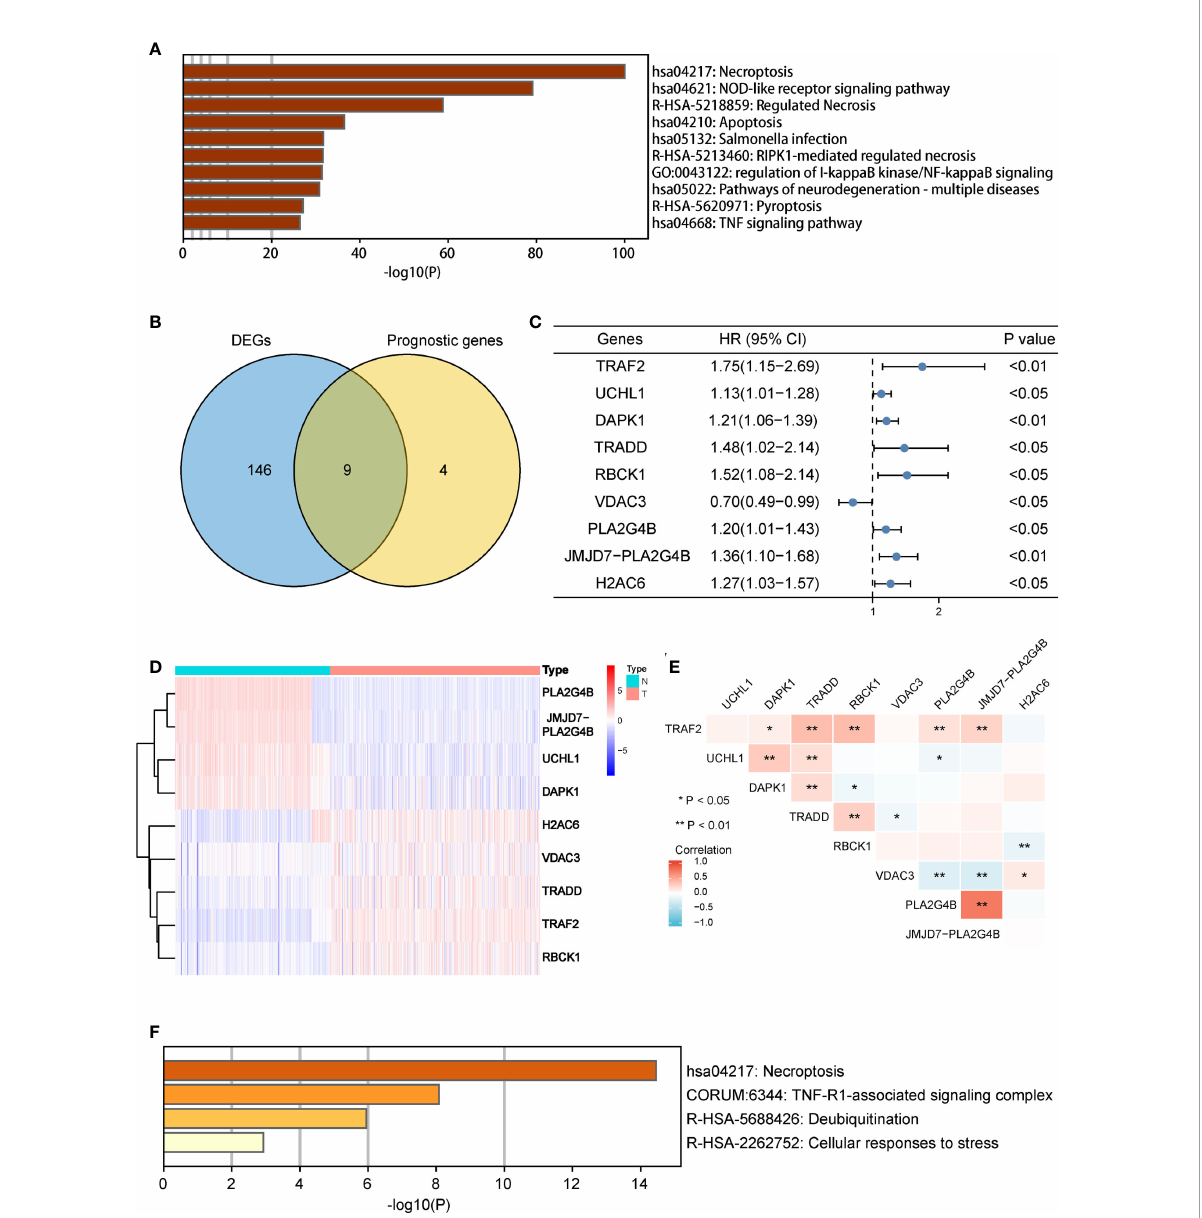
FIGURE 2 Identi fi cation of candidate necroptosis-related DEGs in TCGA cohort. (A) Function enrichment analysis of 155 DEGs by Metascape. (B) Venn diagram to identify candidate genes by taking the intersection between the prognostic genes and DEGs. (C) Forest plot showing the results of univariate Cox regression analysis of nine candidate genes. (D) Heat map showing the expression of nine candidate genes in normal tissues and COAD tissues. (E) Spearman ’ s correlation analysis of the nine candidate genes. (F) Function enrichment analysis of nine candidate genes by Metascape. DEGs, differentially expressed genes; OS, overall survival; TCGA, the Cancer Genome Atlas. *P < 0.05, **P <